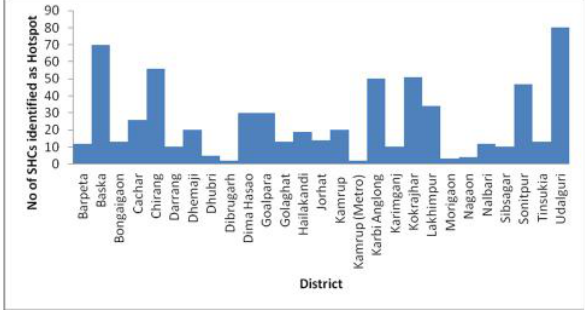
Figure 2. Number of SHCs identified as hotspots in different districts of Assam